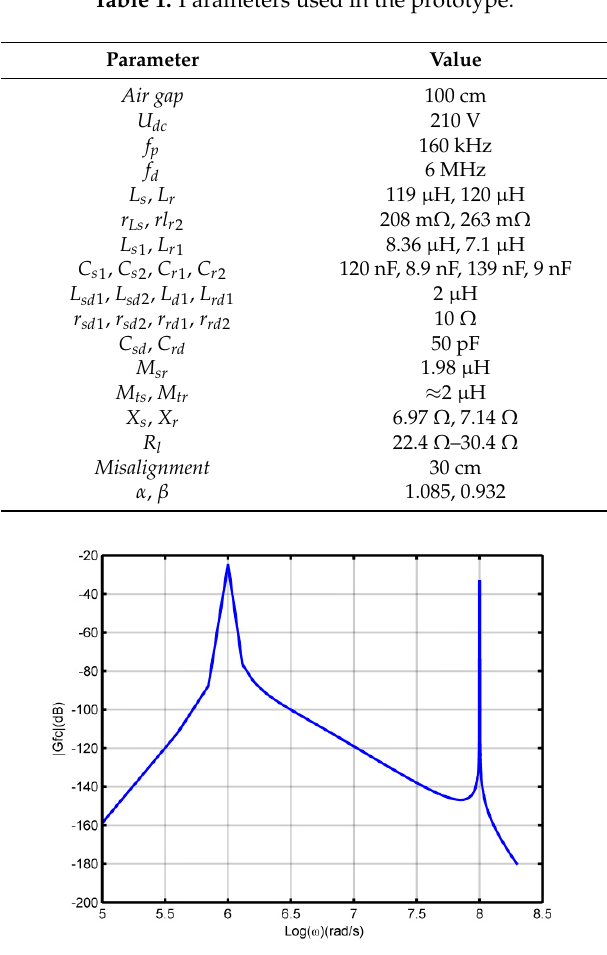
Table 1. Parameters used in the prototype.